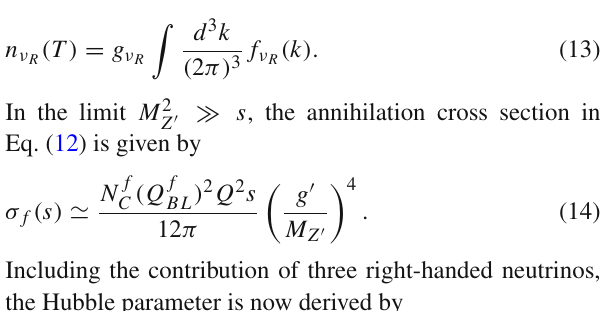
Fig. 3 LHC exclusion limits in the g (cid:2) − M Z (cid:2) for Q = − 1 the U ( 1 ) B − L scotogenic Dirac model. The dashed line corresponds to the LEP limit in Eq. (8)